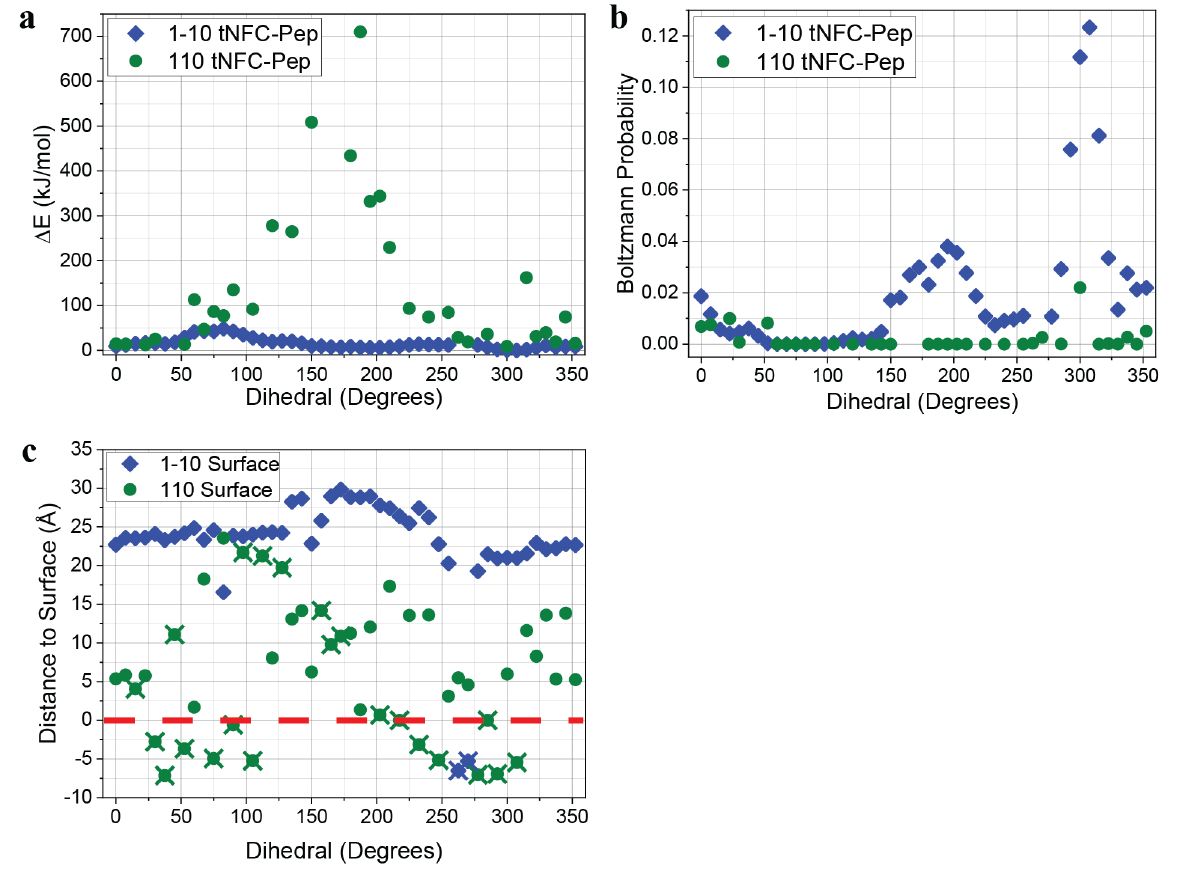
Figure 6. ( a ) Minimized energy for each crystal surface with attached biosensor unit (tNFC-Pep) as a function of the dihedral angle, ( b ) Boltzmann distributions for each surface based on their optimized energies, and ( c ) the distance from the AMC cleavage point to the transducer surface (red dashed line) based on the optimized geometries for each crystal surface. The symbols with an “X” indicate geometries, which did not converge. Thus, the symbols with an “X” indicate calculations that did not fully converge, often because the initial geometry resulted in atomic overlap and are not considered viable structures.